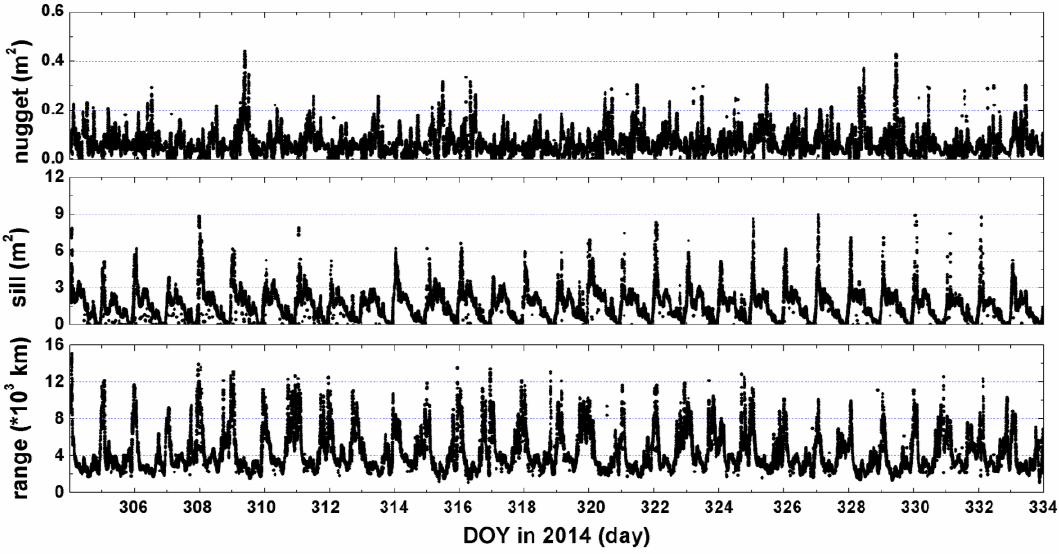
Figure 2. The semivariogram parameters ( nugget , sill , range ) during 2014.11.